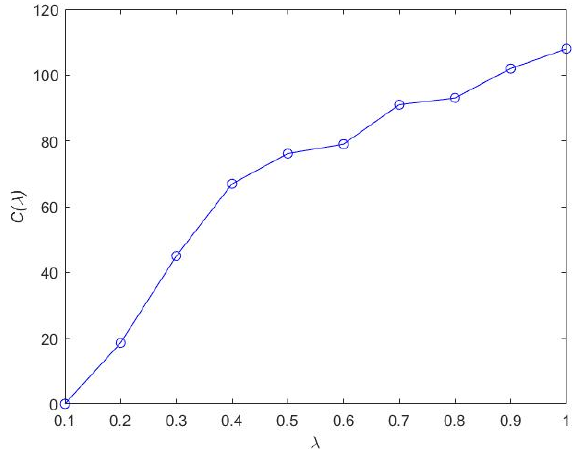
Figure 5. Sensitivity analysis of operating costs on λ